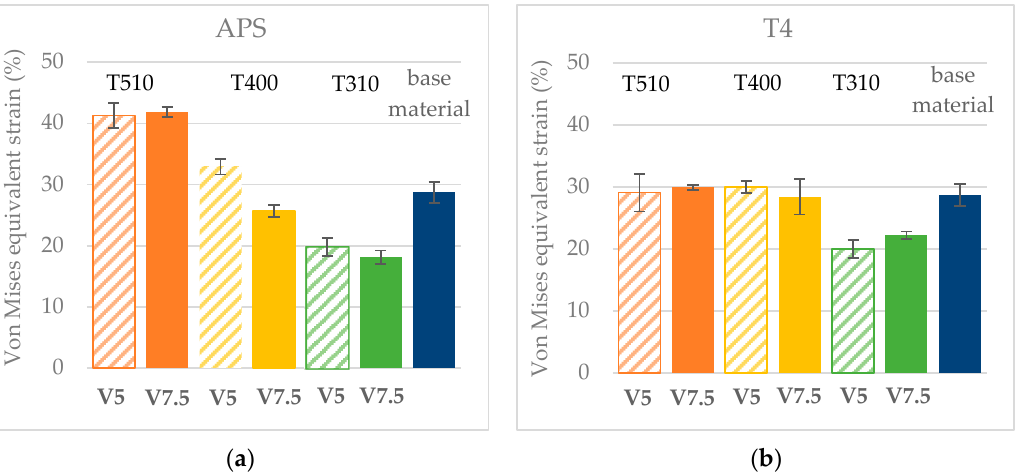
Figure 28. ( a ) Von Mises equivalent strain after physical simulation for all investigated laser condi- tions and comparison with material base; ( b ) Von Mises equivalent strain after natural aging for all investigated laser conditions and comparison with material base.